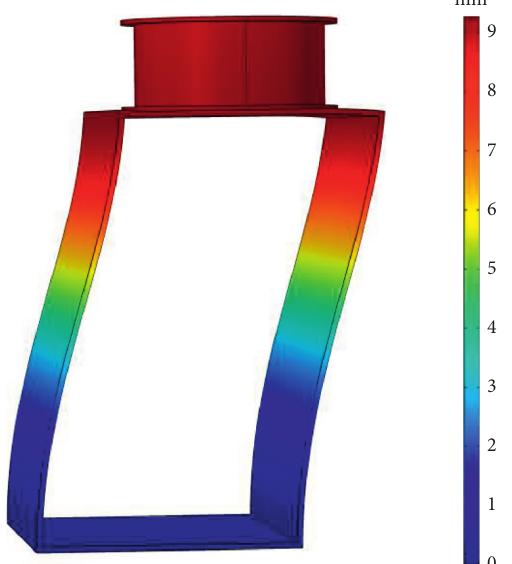
Figure 8: The force diagrams.